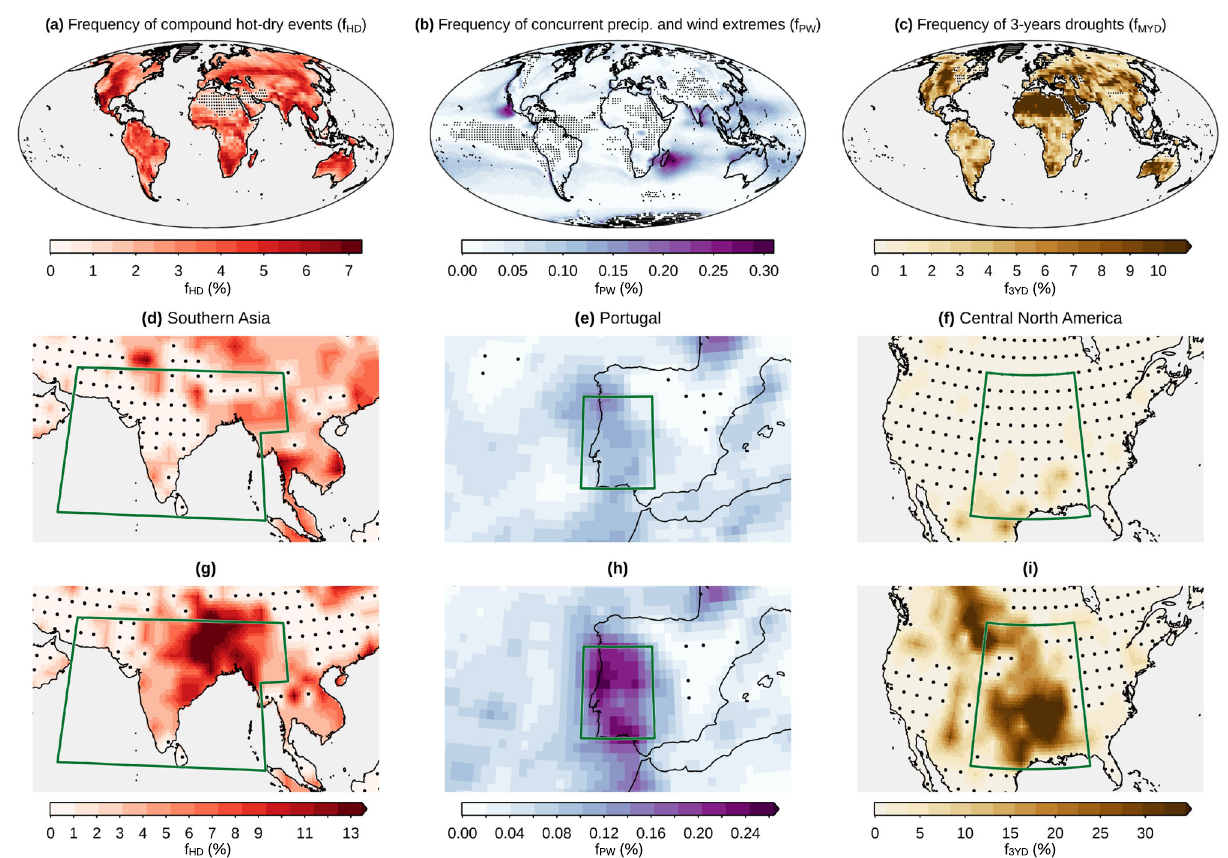
Fig. 1 | Historical (1950 – 1980) frequency of compound events and associated uncertainties. a Ensemble mean frequency of compound hot-dry events ( f HD ; during the warm season) based on the MPI-GE model. Stippling indicates areas where the compound event ensemble-mean frequencyissmaller than expectedin areferencecasethatassumesindependencebetweenthecompounddrivers(here, independence between average temperature and precipitation during the warm season). d , g f HD of the ensemble members associated with the 5th and 95th per- centilesamongstallthemembers,respectively,ofthe f HD averagedovertheregion